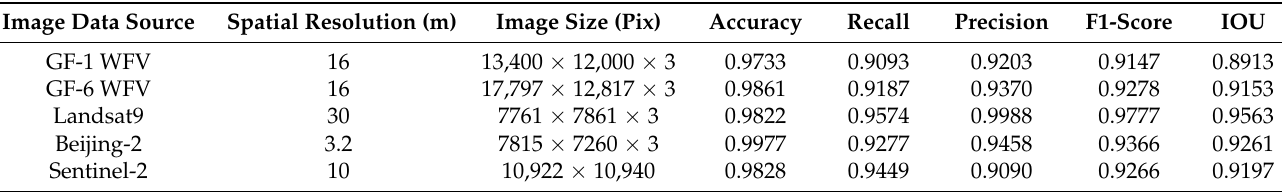
Table 8. Quantitative accuracy of multi-source remote sensing